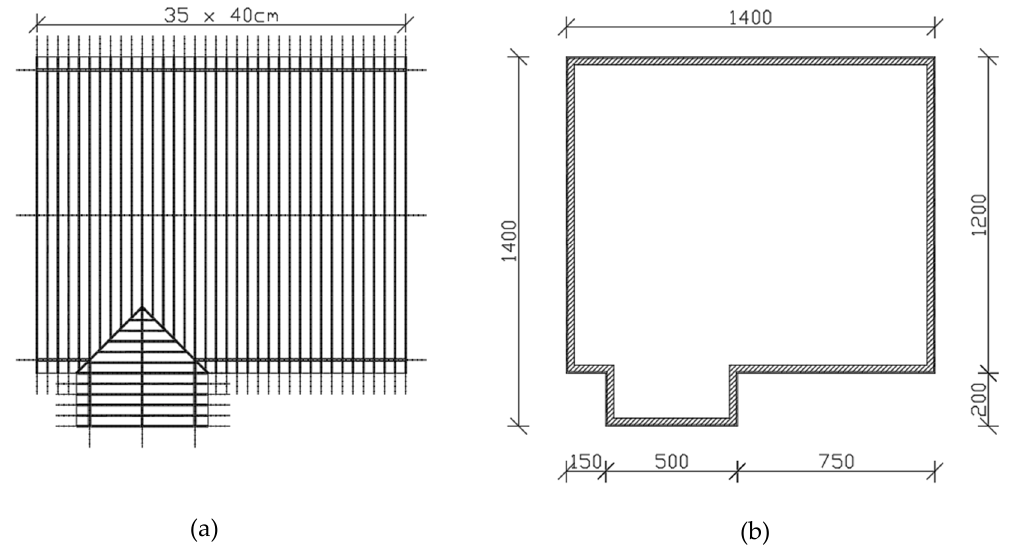
Figure 6. Building’s geometry, ( a ) roof structure layout, ( b ) ground floor layout.